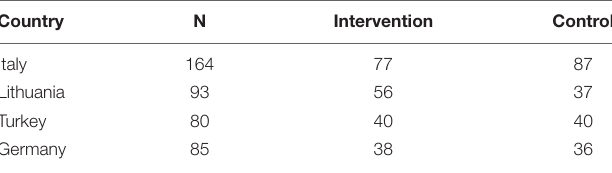
TABLE 1 | Selected participants per country. Country N Intervention